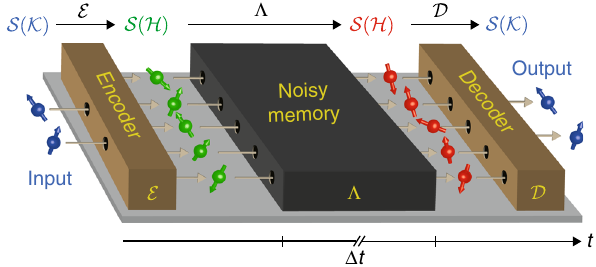
Fig. 1 Time diagram of an error-corrected quantum memory. An